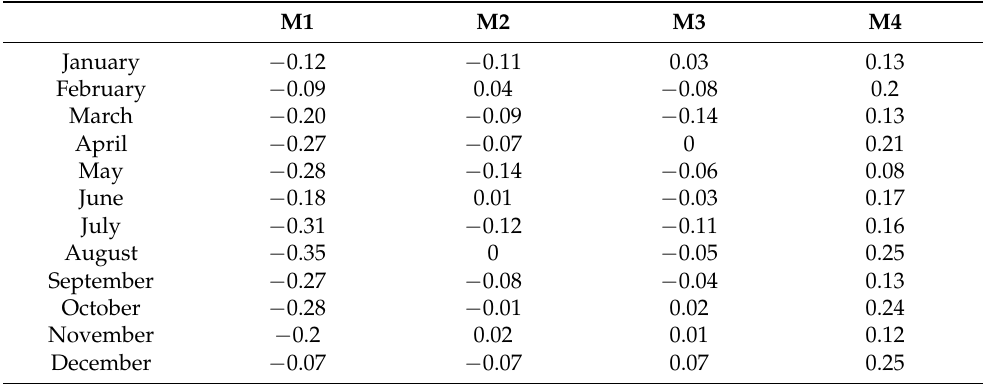
Table 3. Values of the Pearson r linear correlation coefficient between the values of electricity consumption and horizontal insolation in individual months in 4 analyzed cases of mines.